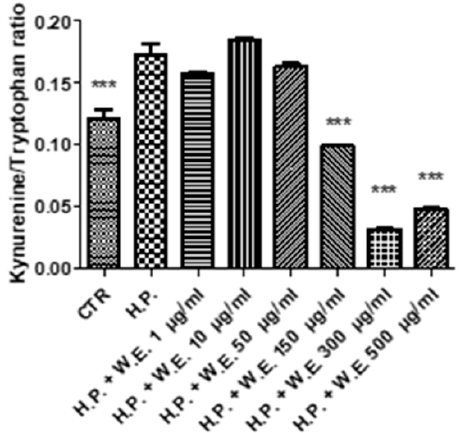
Figure 9. Inhibitory effect induced by Futura 75 water extract (W.E.) on kynurenine/tryptophan ratio increased by hydrogen peroxide (H.P.) 1 mM in isolated mouse skin specimens. ANOVA, p < 0.0001; *** p < 0.001 vs. H.P.